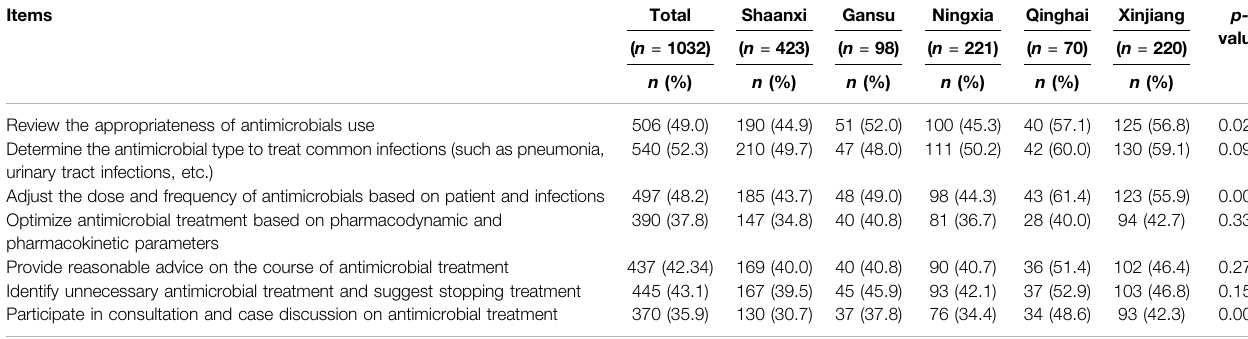
Adjust the dose and frequency of antimicrobials based on patient and infections